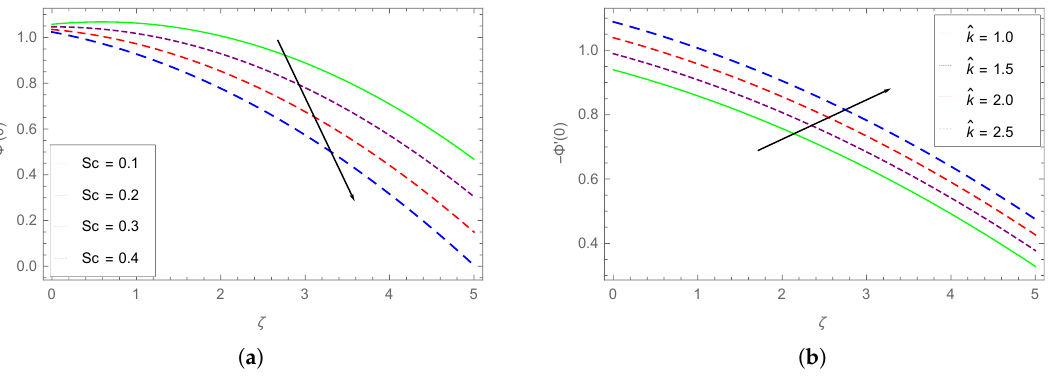
Figure 18. Dependence of Sherwood number on ( a ) Sc and ( b ) ˆ k .